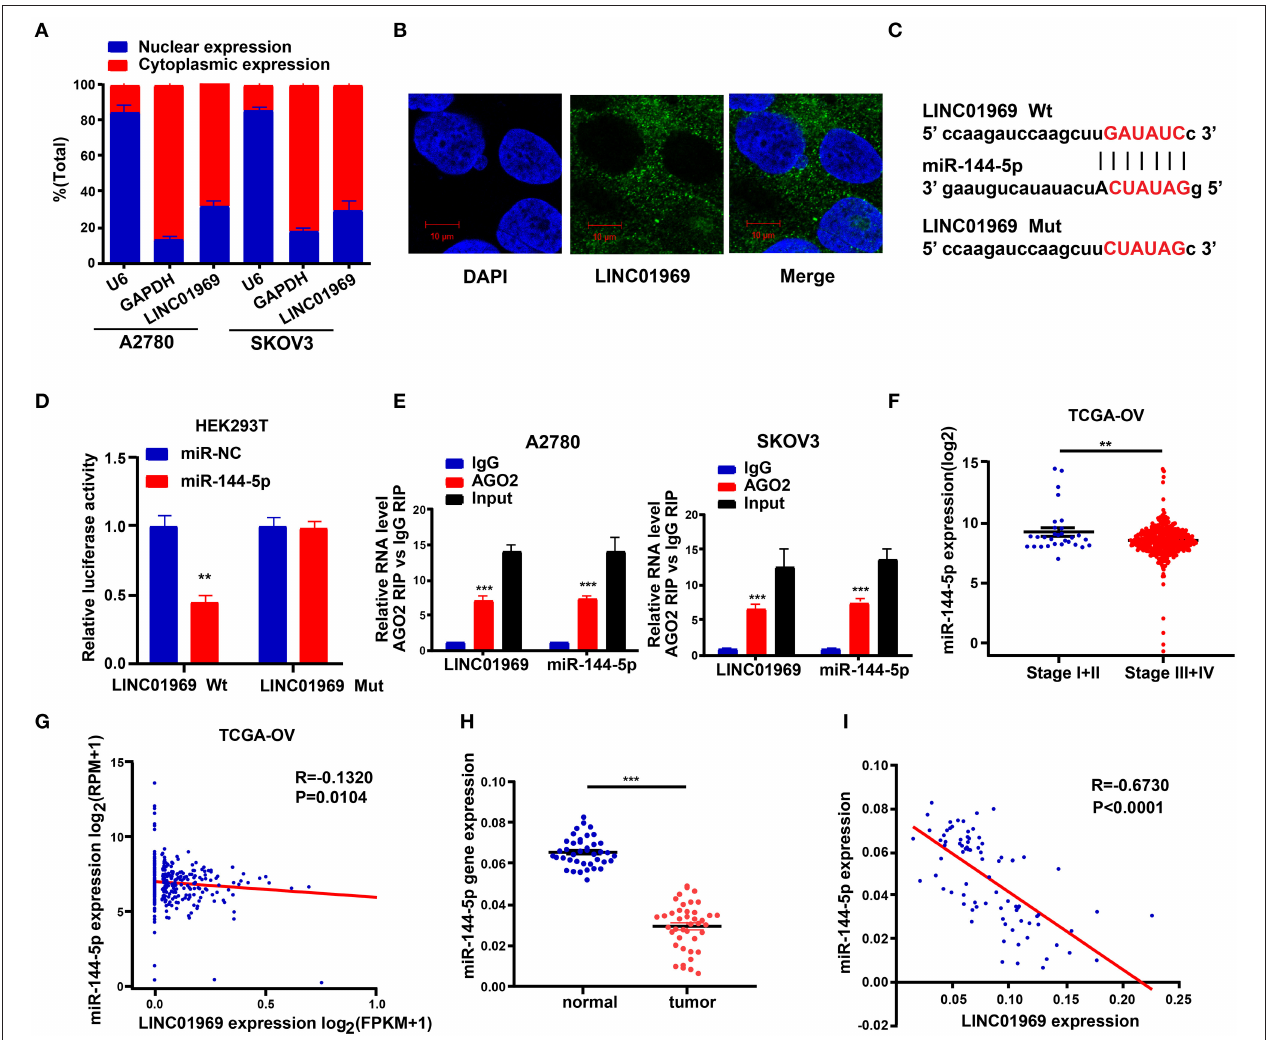
FIGURE 5 | LINC01969 is targeted by miR-144-5p. (A) Localization of LINC01969 by nucleocytoplasmic separation experiment. (B) RNA-FISH in A2780 cells. (C) Putative miR-144-5p binding sequence and mutation sequence of LINC01969 messenger RNA (mRNA) were as shown. (D) Dual luciferase reporter assay was used to confirm the direct target between LINC01969 and miR-144-5p. (E) RNA-binding protein immunoprecipitation (RIP) assay was used to detect whether miR-144-5p could bind with LINC01969 . (F) MiR-144-5p expression in ovarian cancer (OC) stage I + II and stage III + IV, from The Cancer Genome Atlas (TCGA) database. (G) The correlation analysis between miR-144-5p expression and LINC01969 expression in OC from TCGA database. (H) MiR-144-5p expression in OC tissues and paired non-normal tissues. (I) The correlation analysis between miR-144-5p expression and LINC01969 expression in 41 OC tissues and 41 adjacent no normal tissues. Data were presented as mean ± SD; ** P < 0.01, *** P <